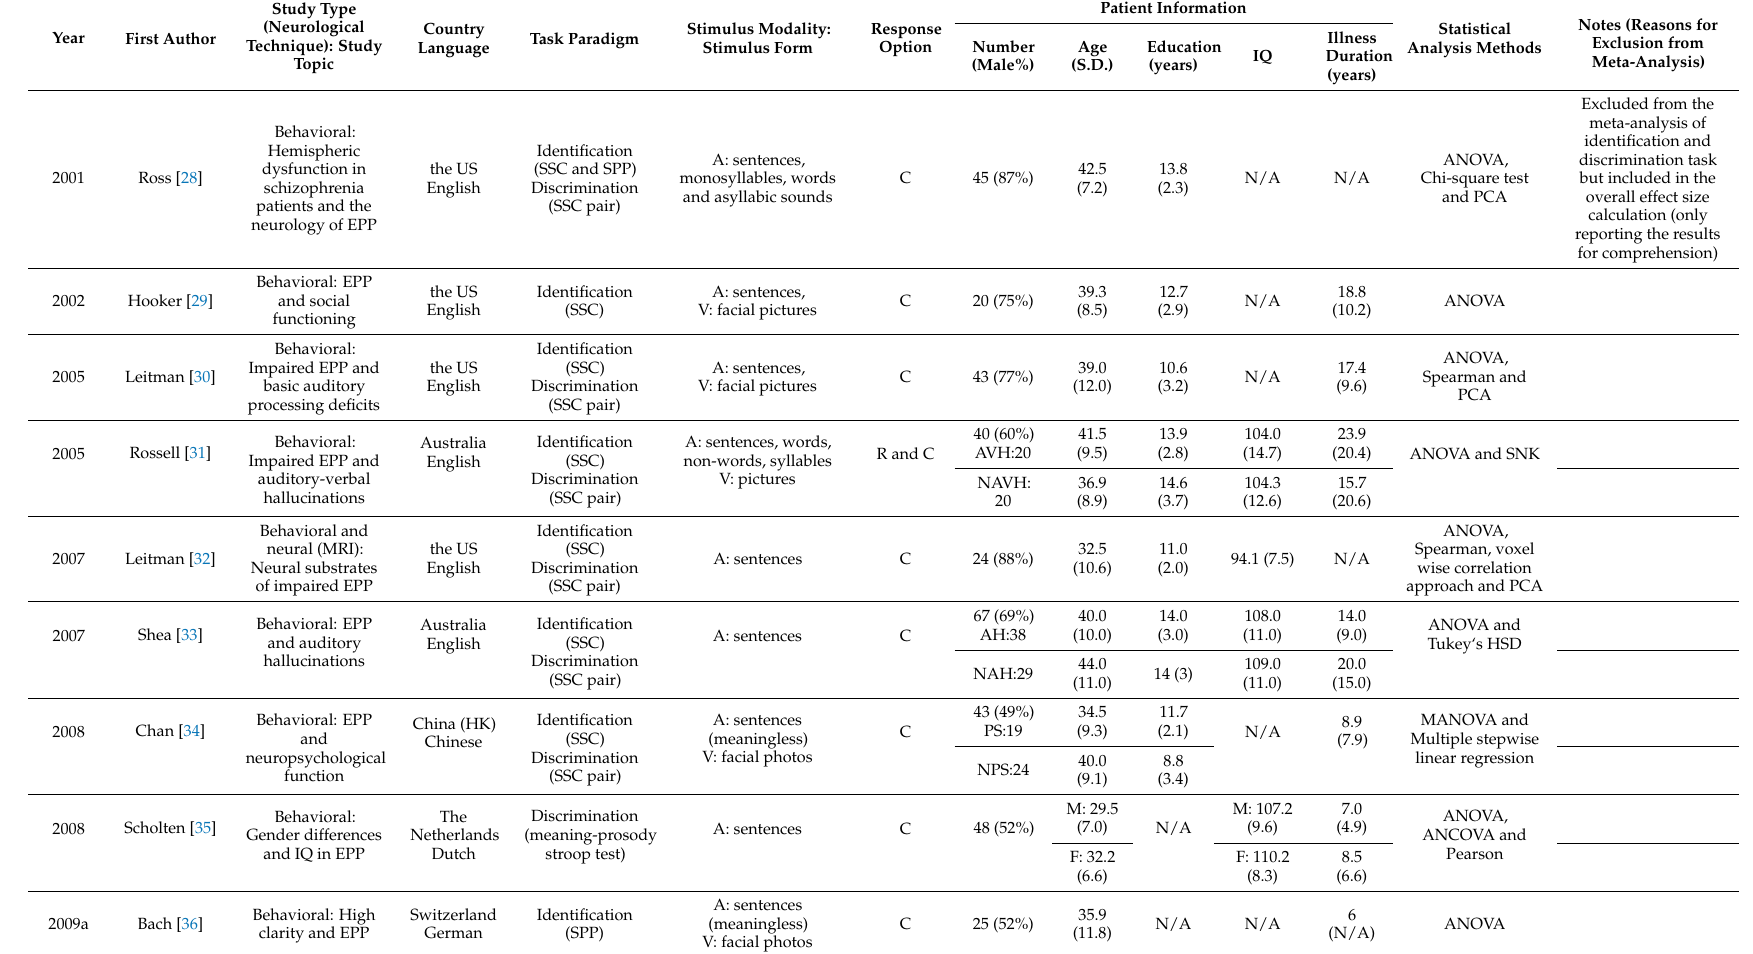
Table 1. Characteristics of studies related to emotional prosody processing (EPP) in